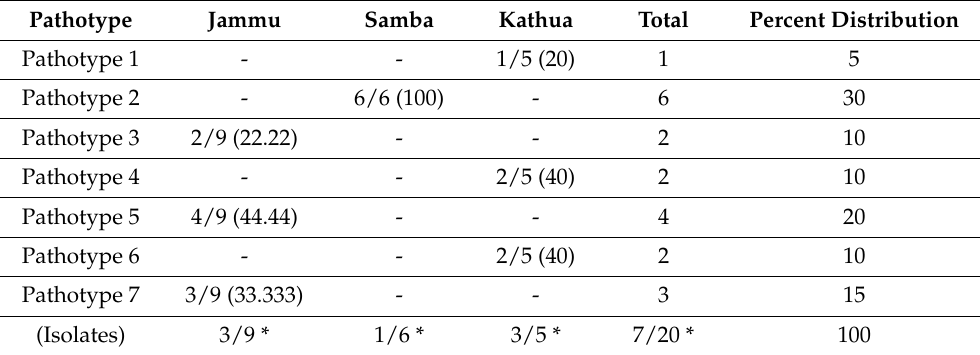
Table 7. Distribution of Xanthomonas oryzae pv. oryzae pathotypes in various districts of Jammu